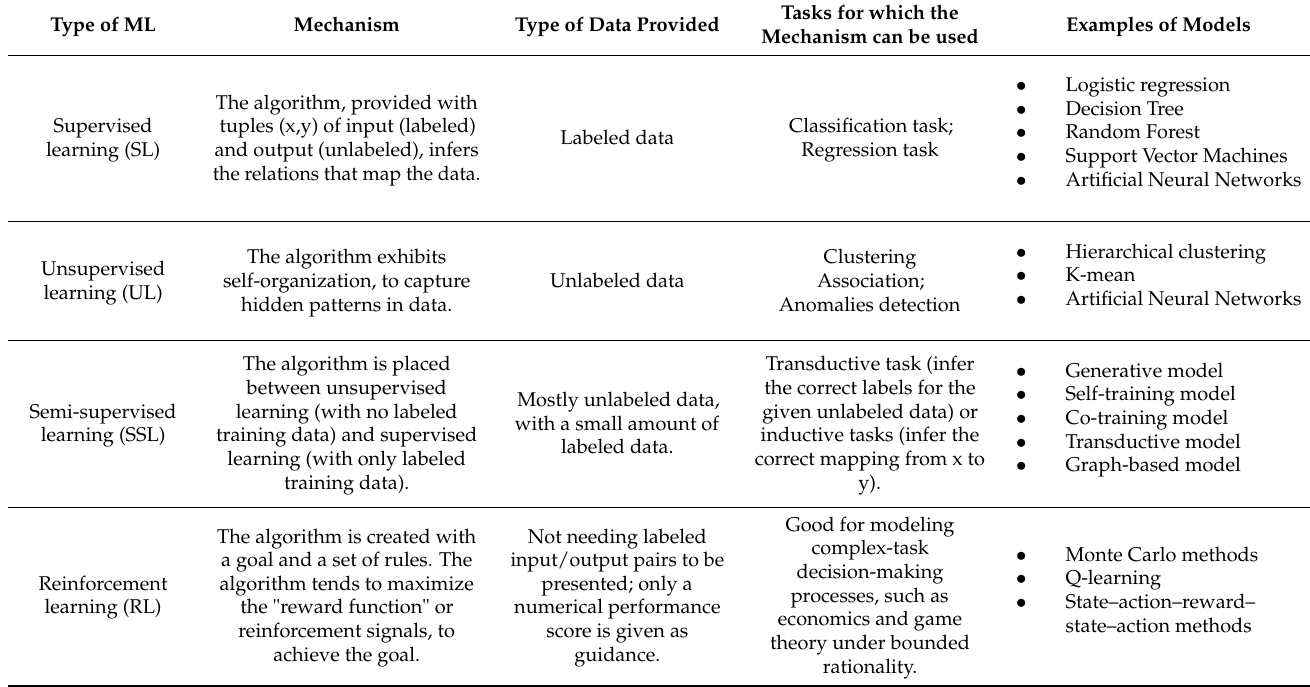
Figure 1. Graphic explanation of the functions that AI tools can carry out in emergency radiology. Table 1. This table shows the main characteristics of different types of machine learning